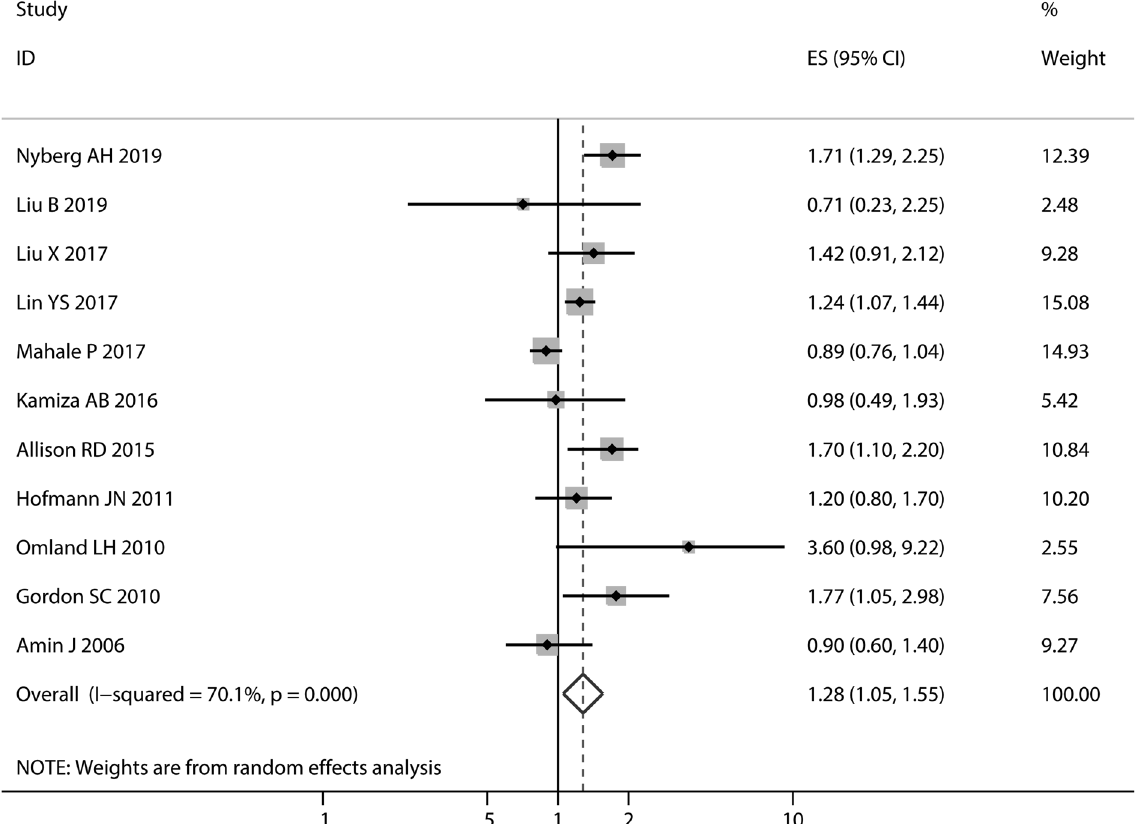
Figure 1. Forest plots of relative risk of studies investigating the association between hepatitis C virus infection and renal cell cancer. Random effects models were used for the primary